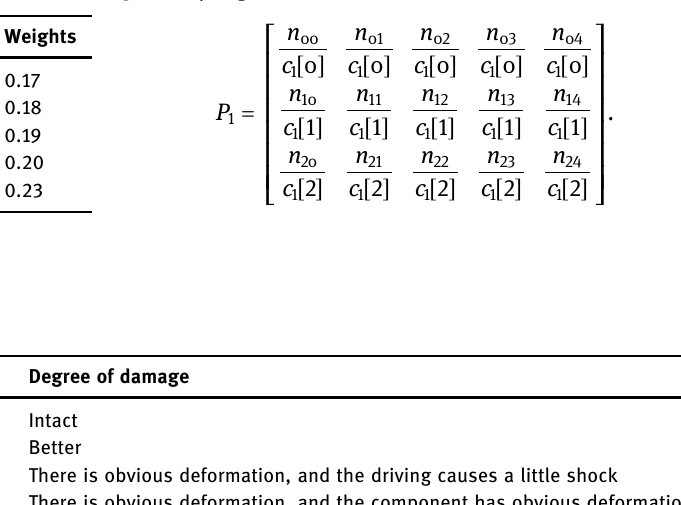
Table 1: Comparison of damage grade, grade score, and weight